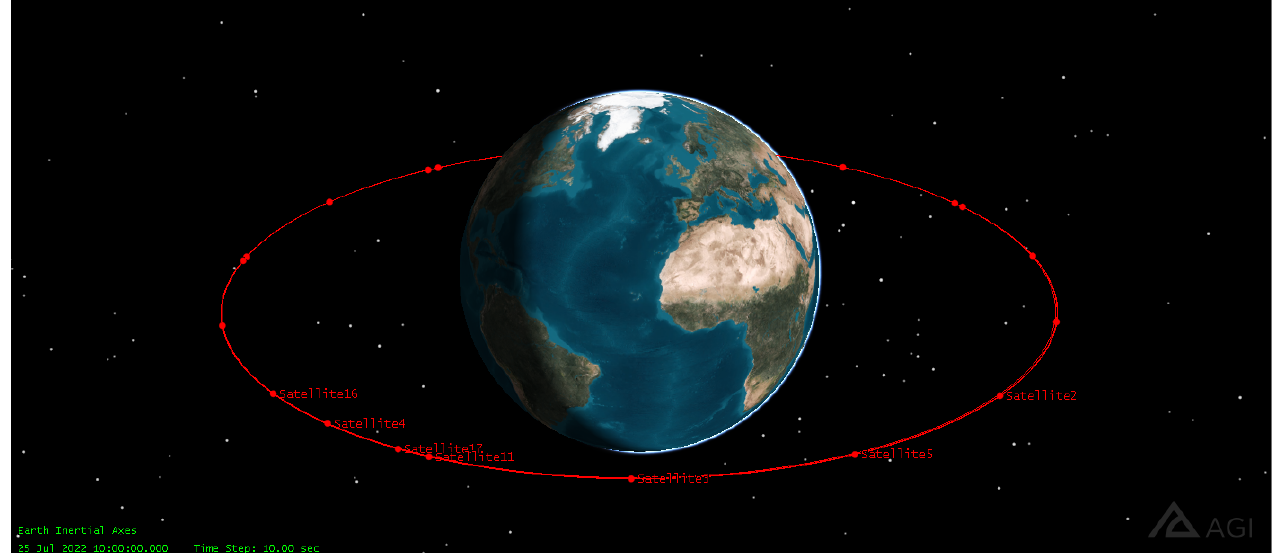
Figure 6. As part of the constellation, a total of 20 satellites are deployed in a circular orbit along the equator at an altitude of 8063 km in MEO